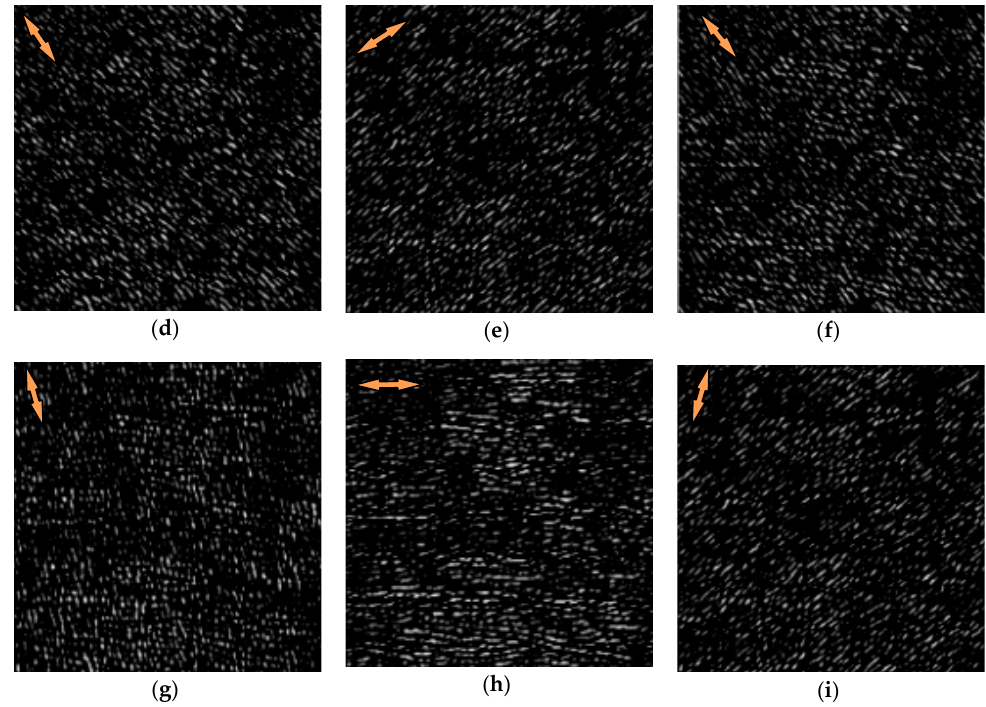
Figure 6. NSCT decomposition image results. ( a ) Original image. ( b ) Low-frequency sub-bands. ( c – i ) High-frequency directional sub-bands.